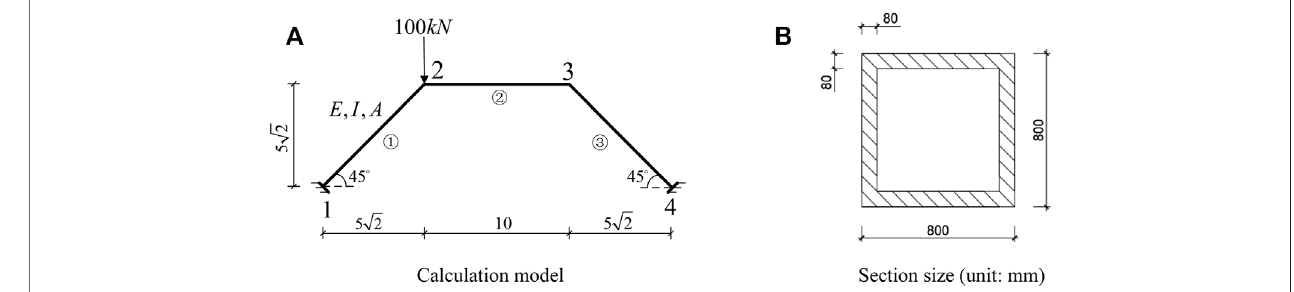
FIGURE 4 | Calculation model and the section size of the rigid frame. (A) Calculation model. (B) Section size (unit: mm).